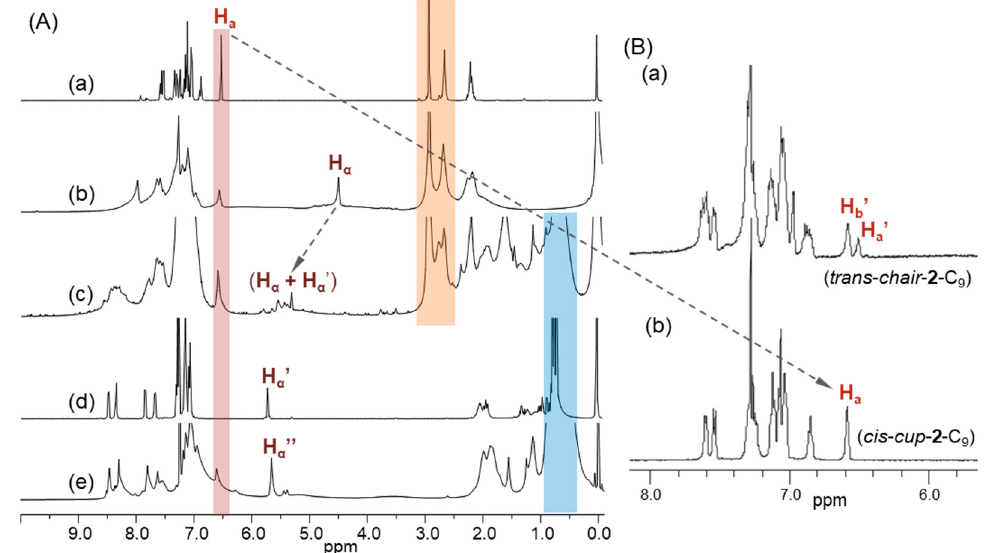
Figure 2. 1 H-NMR spectra (CDCl 3 ) of ( A ) (a) tris(DPAF-C 2M ) ( 2 -C 2M ), (b) tris(BrDPAF-C 2M ) ( 3 -C 2M ), (c) tris[(DPAF-C 2M )-C 60 (>DPAF-C 9 )] ( 4 -C 2M − 9 ), (d) C 60 (>DPAF-C 9 ) ( 1 -C 9 ), and (e) tris[C 60 (>DPAF-C 9 )]. ( B ) 1 H-NMR spectra (CDCl 3 ) of (a) trans - chair -tris(DPAF-C 9 ) ( trans - chair - 2 -C 9 ) and (b) cis - cup -tris(DPAF-C 9 ) ( cis - cup - 2 -C 9 ) for comparison.